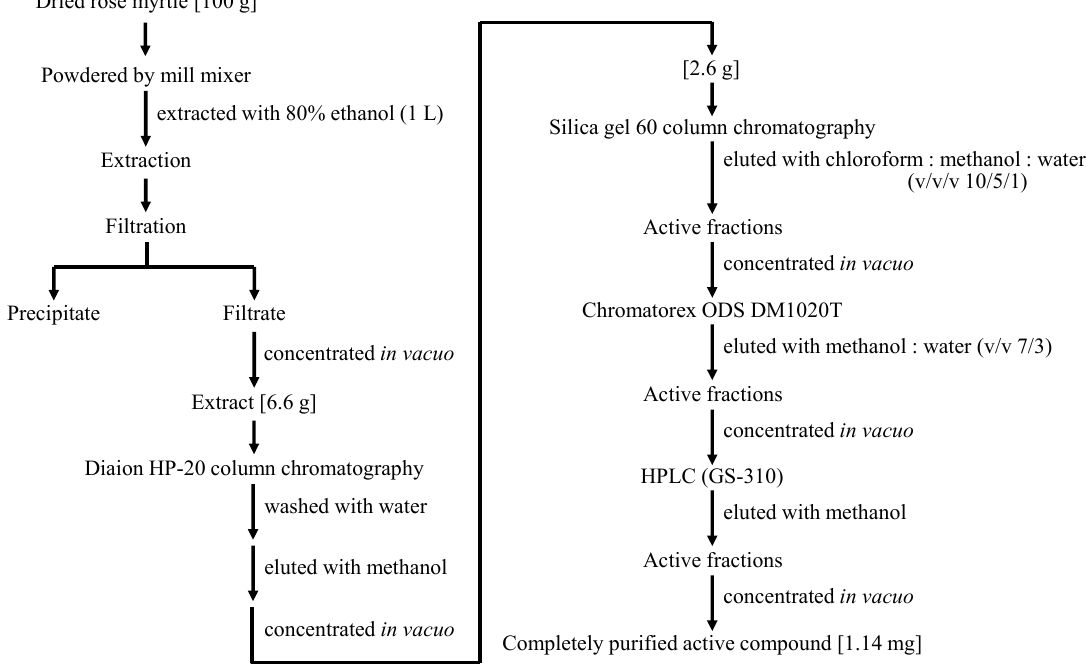
Figure 5. Purification procedure of Pol enhancer form rose myrtle.